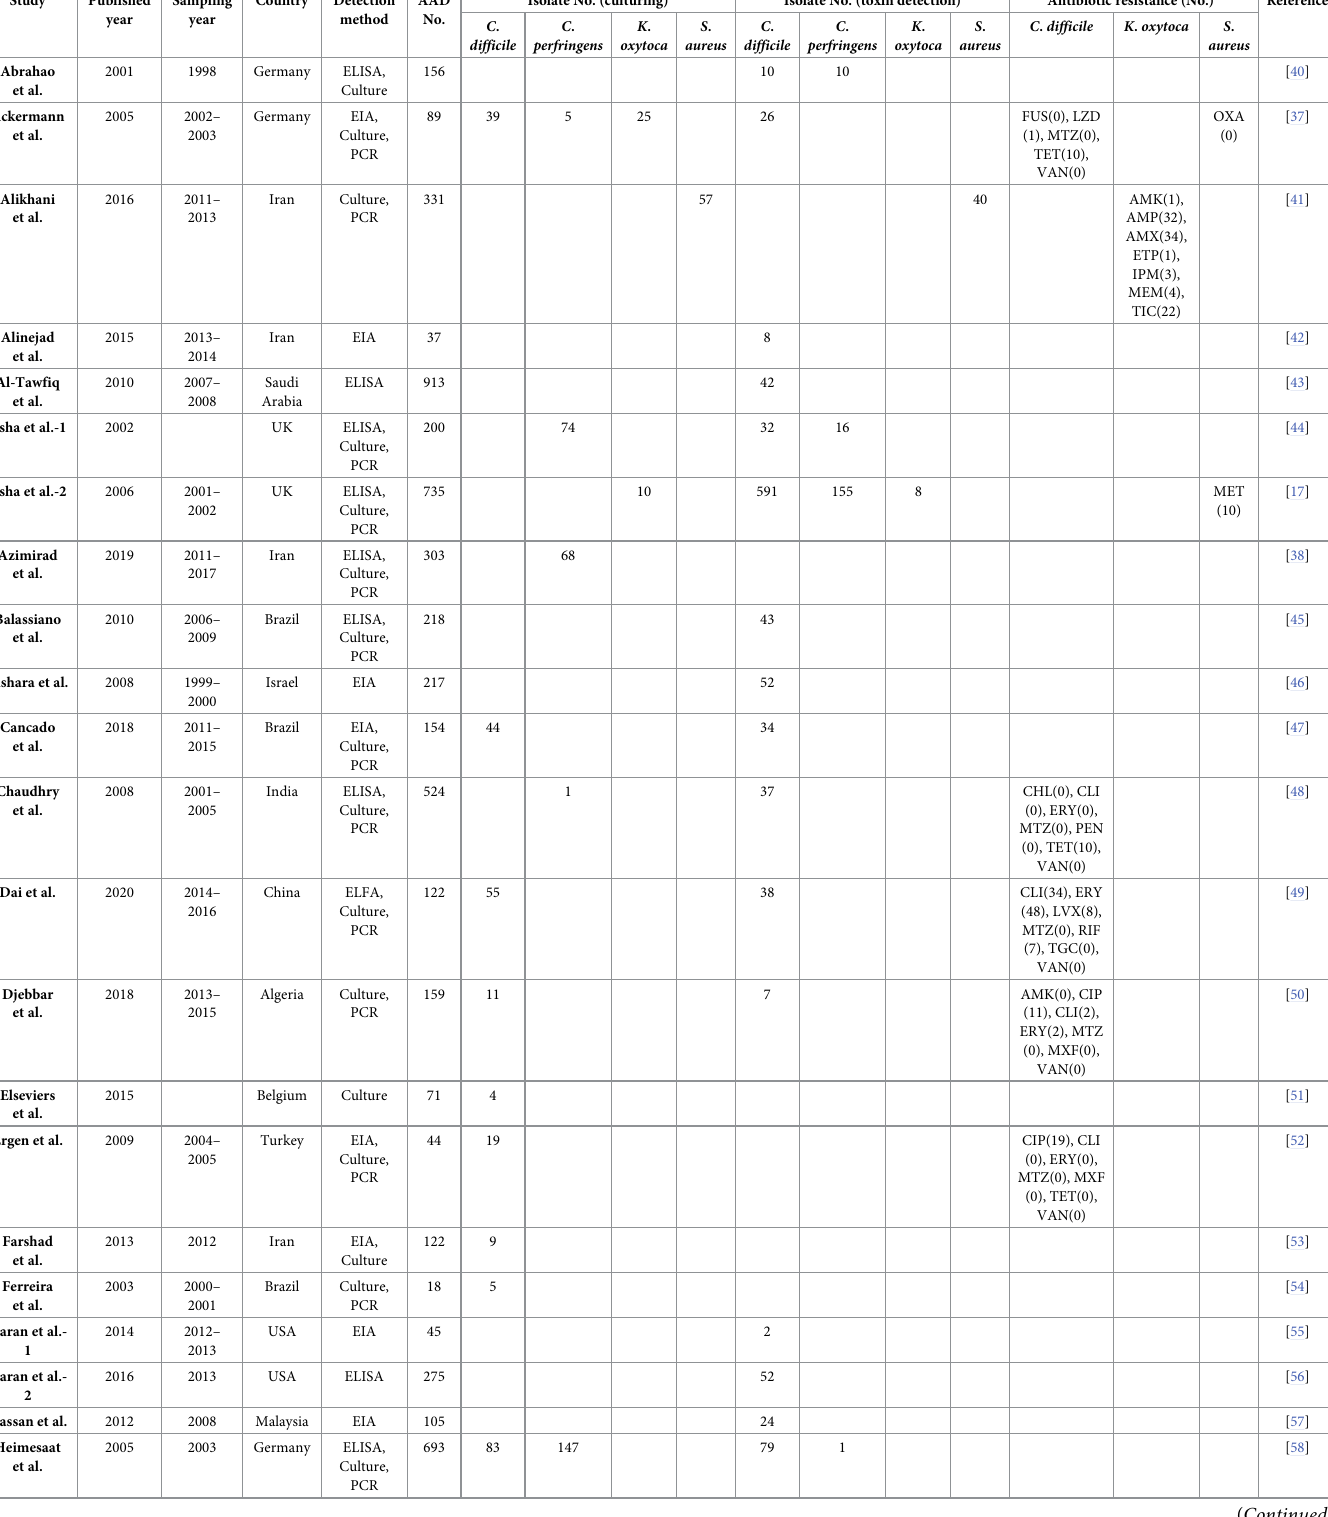
Table 1. The characteristics of the studies. Study